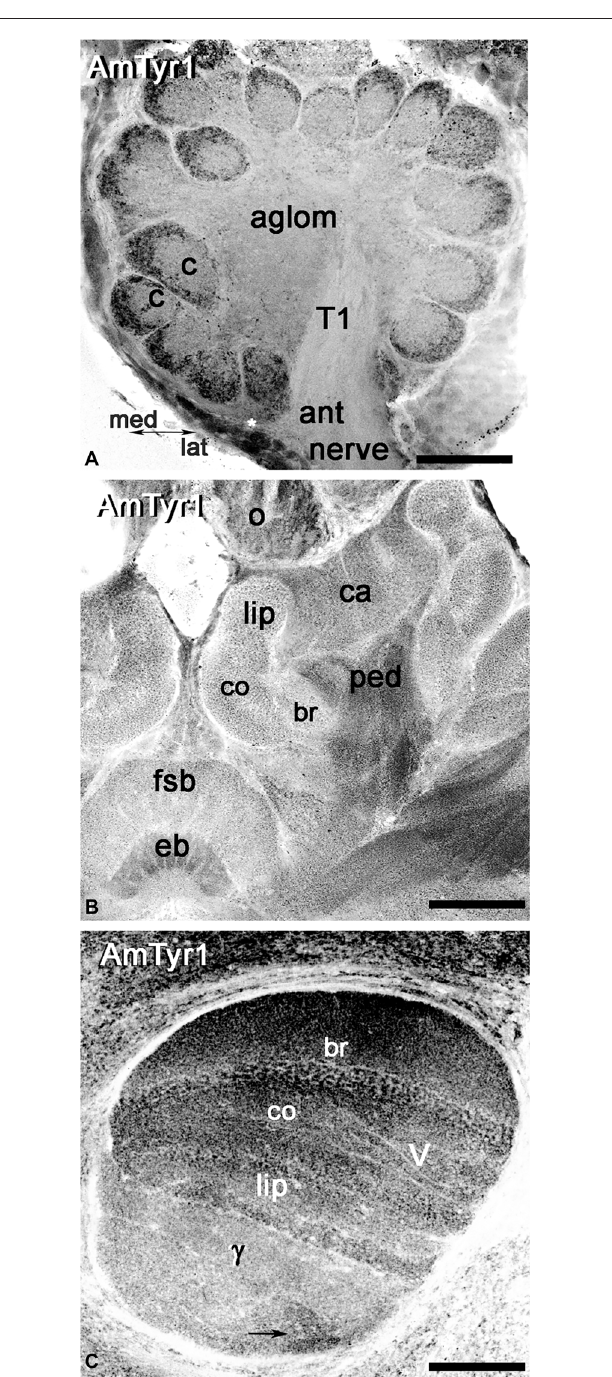
FIGURE 4 | Anti-AmTyr1 labeled the neuropil in the honey bee brain. (A) In the antennal lobe, the anti-AmTyr1 is in the cortex area of each glomerulus, but not in the glomerular core (c) and not in the aglomerular neuropil (aglom). The anti-AmTyr1 staining is also absent in the antennal nerve (ant nerve) and olfactory neuron axons tract T1. Asterisk shows a subset of the AmTyr1 positive medial group cell bodies. (B) All area of mushroom body calyx (ca) and pedunculus (ped) were labeled with anti-AmTyr1 with various level of intensity. There is a higher density of staining in the pedunculus (ped) of